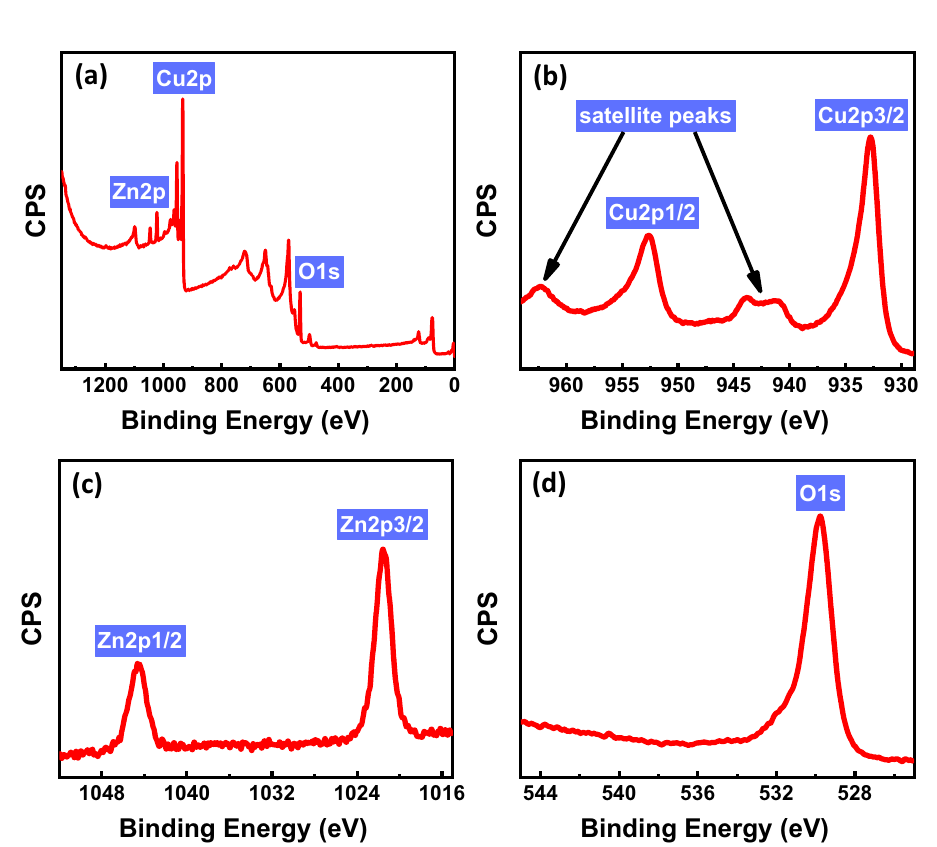
Figure 2. ( a ) XPS survey spectra, high-resolution XPS scans of ( b ) Cu 2p, ( c ) Zn 2p, and ( d ) O 1 s for the fabricated photocathode annealed at 350 °C in the air for 1